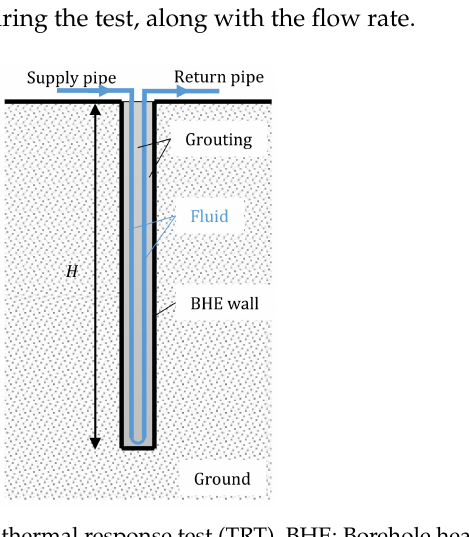
Figure 1. Nomenclature for the thermal response test (TRT). BHE: Borehole heat